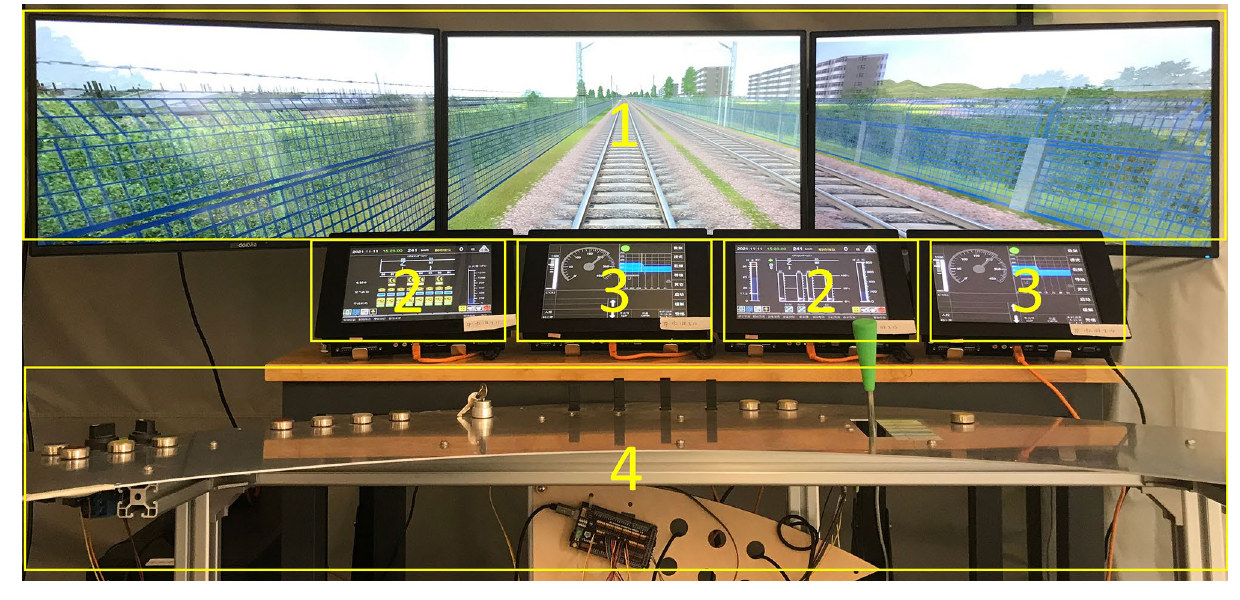
Figure 1. Simulated driving device. The simulation scenarios are displayed on Area 1. Area 2 is the Train Control and Monitor System (TCMS) display screen, which contains information about the vehicle’s state. Area 3 is the Automatic Train Protection (ATP) display screen, which contains information about train driving and protection. The simulator console is located in Area 4.